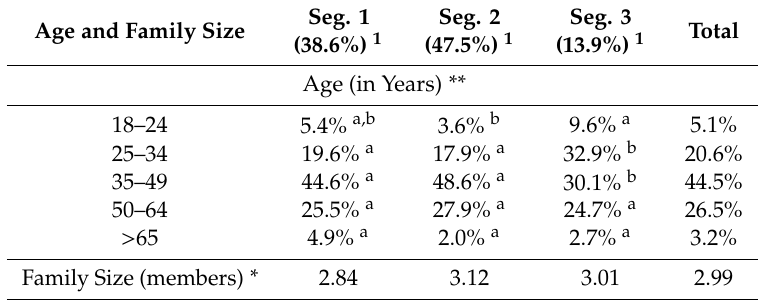
Table 8. Age and family size of the consumer segments by their assessment of the purchase